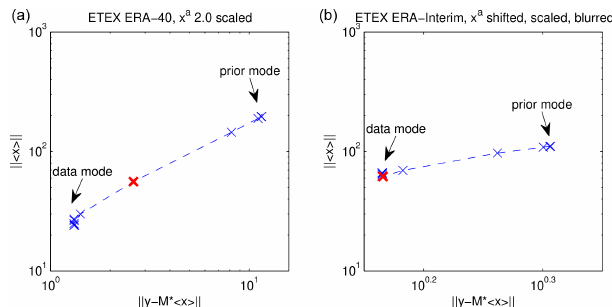
Figure 2. L-curve-type plots using the optimization algorithm with (cid:15) = 1 e − 5 from ETEX ERA-40 with x a 2.0 scaled (a) and from ETEX ERA-Interim with x a shifted, scaled, and blurred (b) . The red crosses denote “sweet